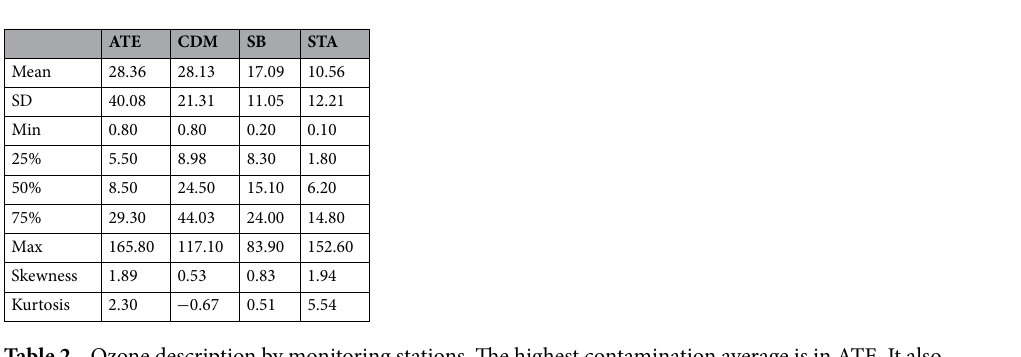
Table 2. Ozone description by monitoring stations. The highest contamination average is in ATE. It also reports the highest pollution indices, presenting a positive asymmetry. Likewise, SB is the one with the lowest contamination